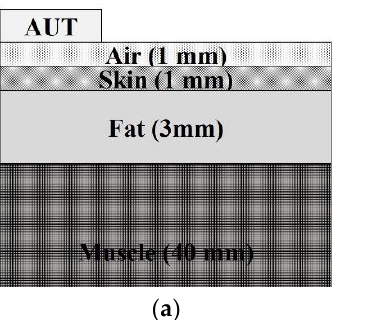
Figure 3. ( a ) Cotton top-view; ( b ) Cotton bottom-view; ( c ) Jeans; ( d ) Viscose; ( e ) Lycra; ( f ) Cotton Case B—9.45 GHz and ( g ) Cotton Case C—38 GHz.